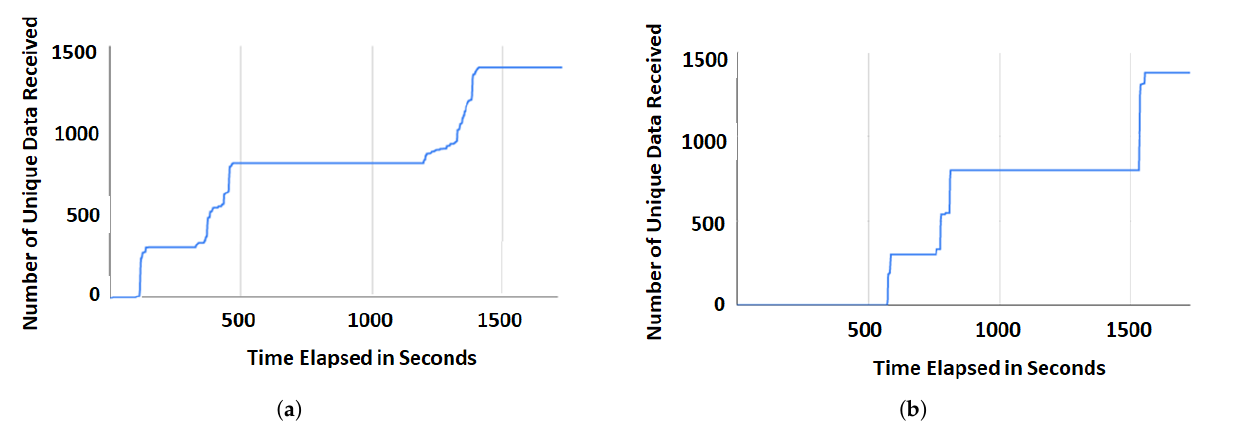
Figure 8. Number of unique data (chunks) received during the experiment. ( a ) Data downloaded by the vehicle. ( b ) Data downloaded by the pedestrian.